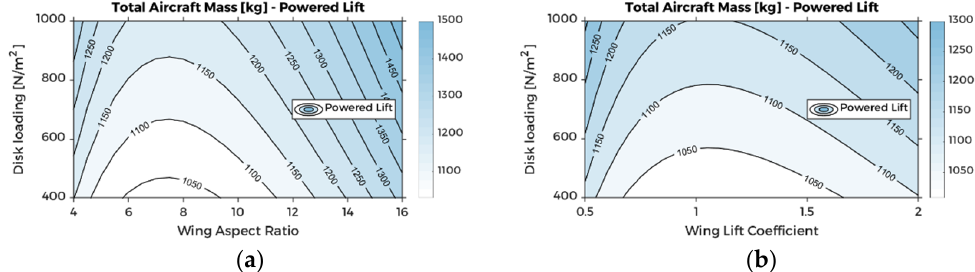
Figure 10. Aircraft mass sensitivities to ( a ) wing aspect ratio and ( b ) wing lift coefficient for the powered lift eVTOL aircraft type.